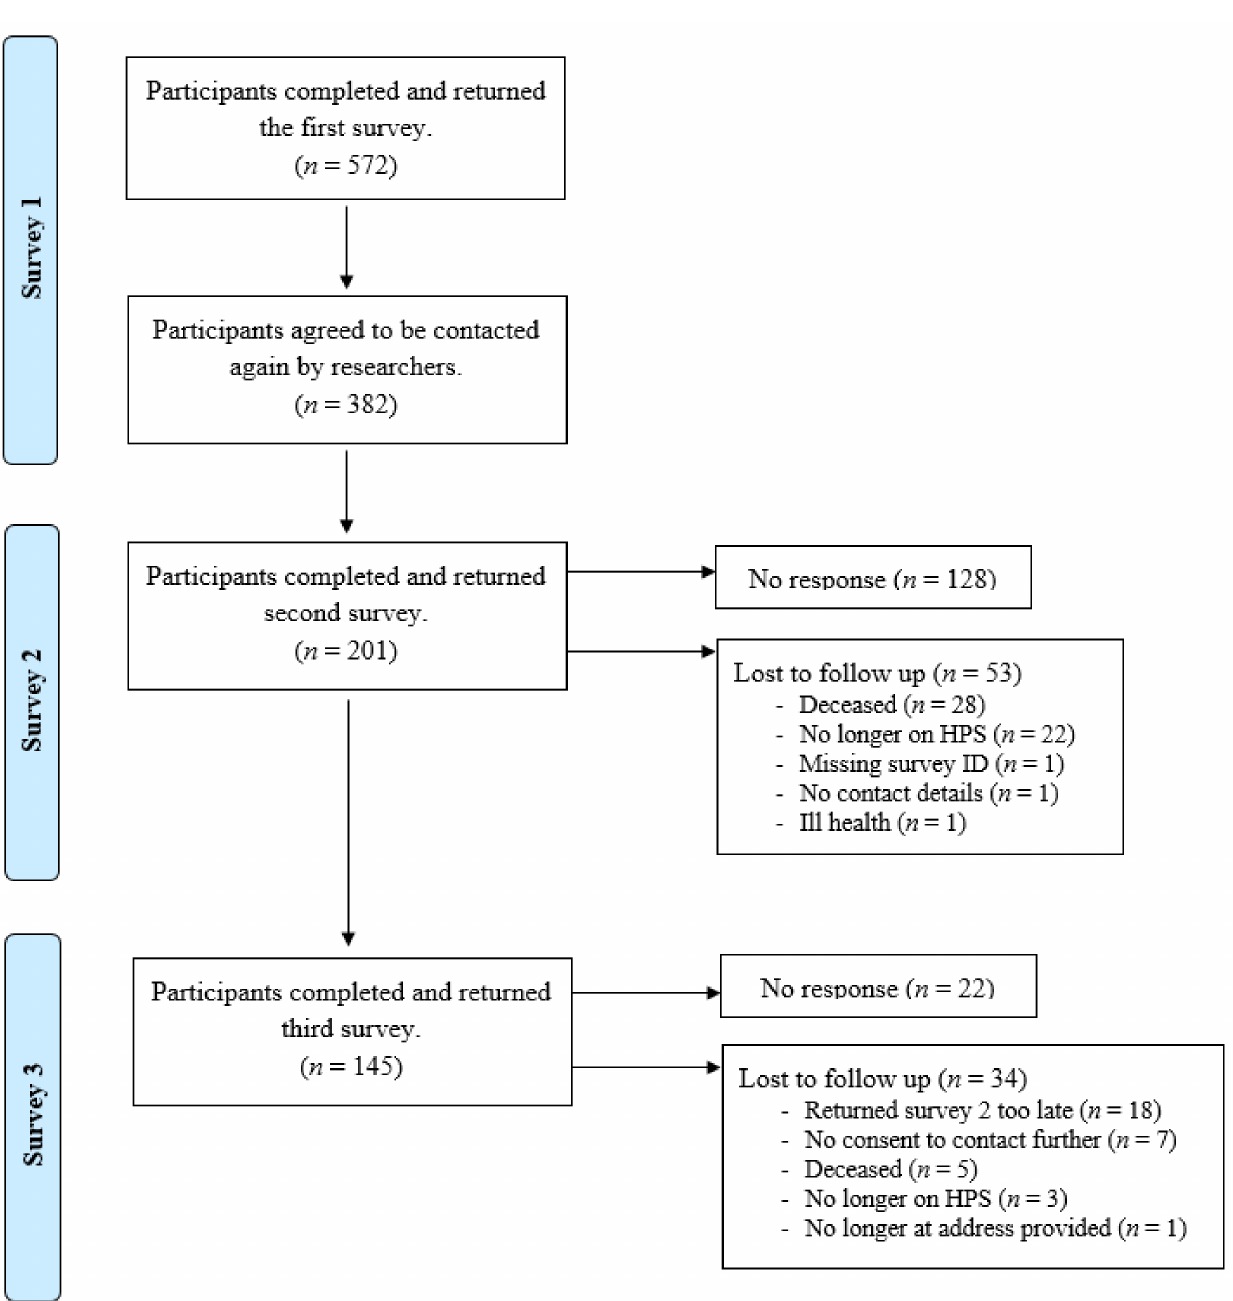
Figure 1. Flow diagram for participant recruitment and retention over